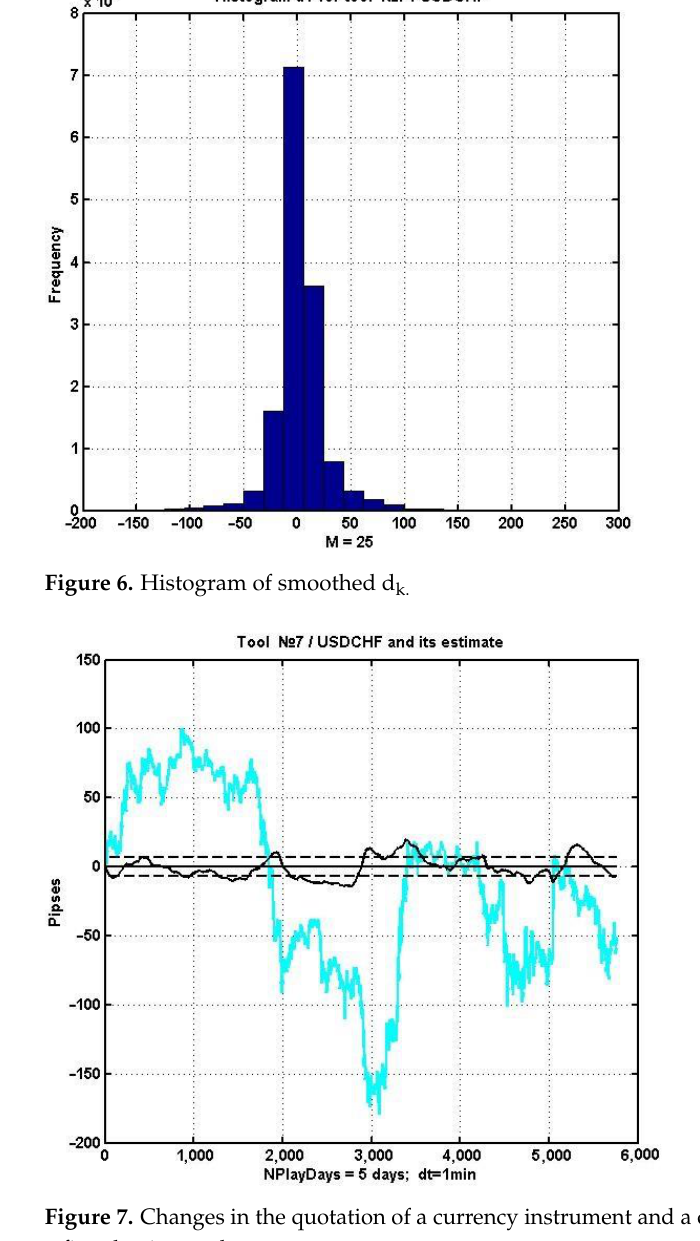
Figure 6. Histogram of smoothed d k.